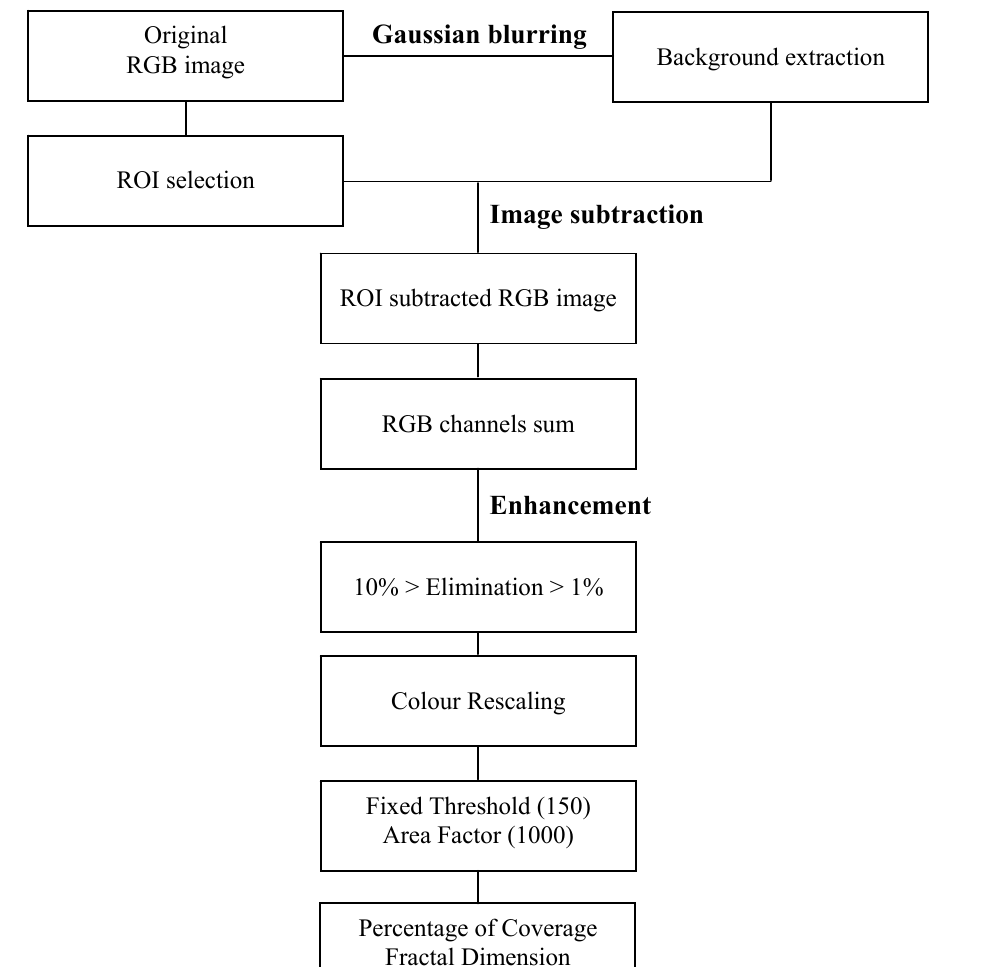
Figure 4. Flowchart detailing the different steps of the protocol for the automated estimation of bacterial mat ( Beggiatoa spp.) coverage in images from the VENUS cabled